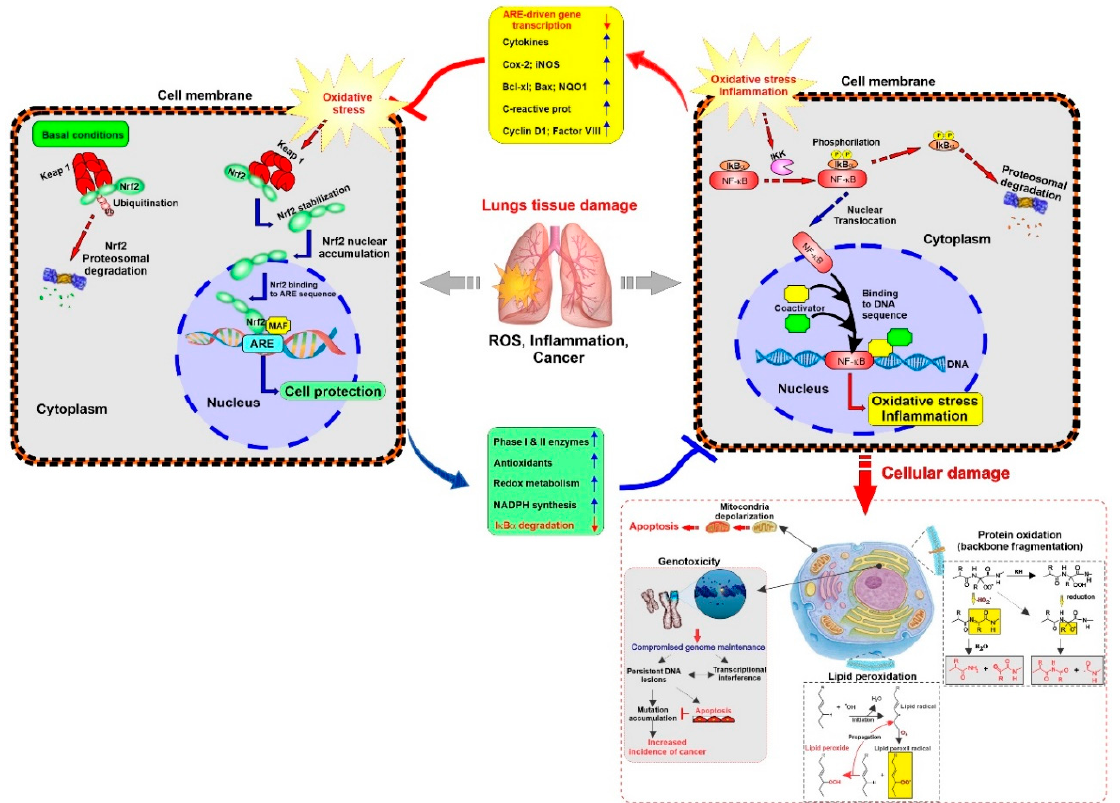
Figure 4. Reactive oxygen species (ROS) promote cellular inflammatory response and oxidative damage, which may impact cell and tissue viability in the lungs. The figure is a schematic illustration depicting the primary point of mutual interference between Nrf2 and NF- κ B. Note the cellular regulation of Nrf2 and NF- κ B under normal and stressed conditions. Both Nrf2 and NF- κ B are nuclear transcription factors that balance and counteract each other’s activity. Note also that the predominant activation of the NF- κ B pathway through ROS exposure (generated either endogenously and / or exogenously) promotes genotoxicity, lipid peroxidation, and protein degradation leading to cellular and tissue damage.